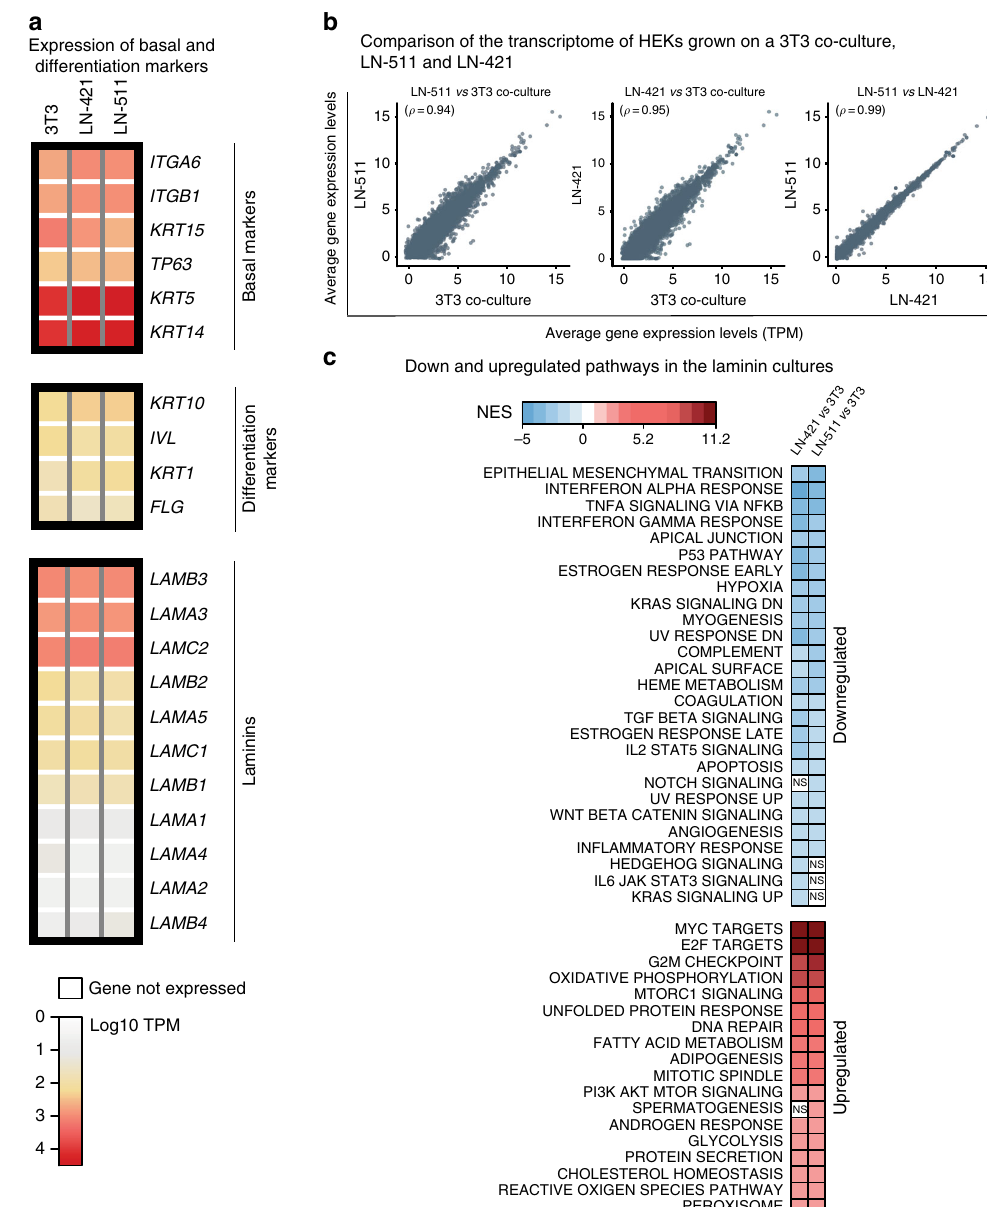
Fig. 3 Transcriptomic pro fi le of HEKs cultured on laminin system. a Heatmap with expression levels of laminin genes and basal and differentiation keratinocyte marker genes (averaged across biological replicates and represented as log10 of transcripts per million, TPM). b Correlation between the transcriptome of keratinocytes grown on a 3T3 co-culture, LN-421, and LN-511. Dots represent individual gene expression levels (averaged across biological replicates per culturing method). ρ denotes Spearman ’ s rank correlation coef fi cient (rho). c Functional up- and downregulated processes in keratinocytes growing on LN-421 and on LN-511, when comparing against keratinocytes growing on 3T3-J2 feeder cells. Functional enrichment was computed by Gene Set Enrichment Analysis (GSEA). NES represents the strength of the enrichment and it denotes normalized enrichment score. Nonsigni fi cant processes are indicated with “ NS ” , the rest of processes are all signi fi cantly enriched (false discovery rate (FDR) < 0.05). See Methods for more